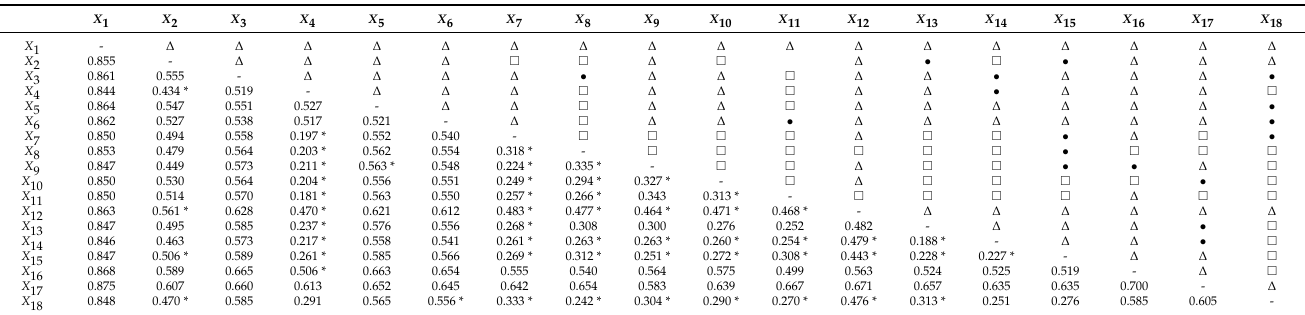
Table 5. Mean superimposed q -value and interaction type between 18 factors at 7 grid-scales